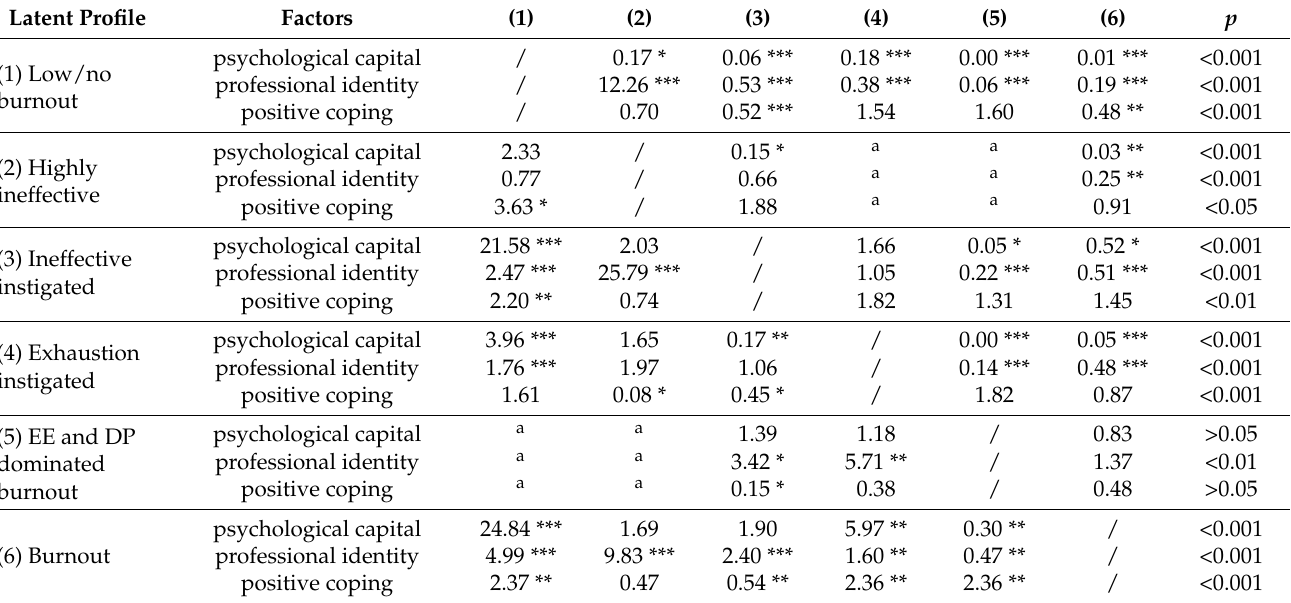
Table 6. The OR of transition from T1 to T2 with the effects of resilience and positive